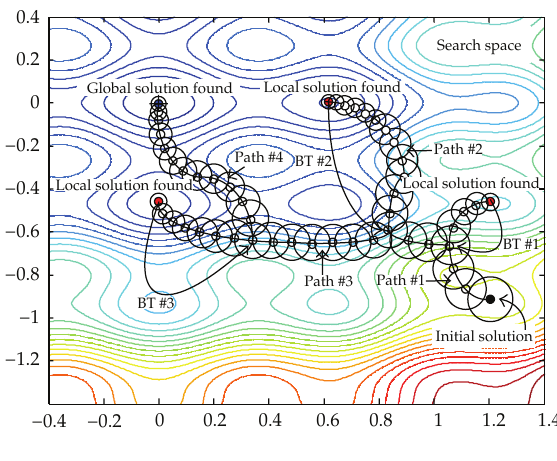
Figure 2: Movements of the ATS. Table 1: Summary of the surface optimization